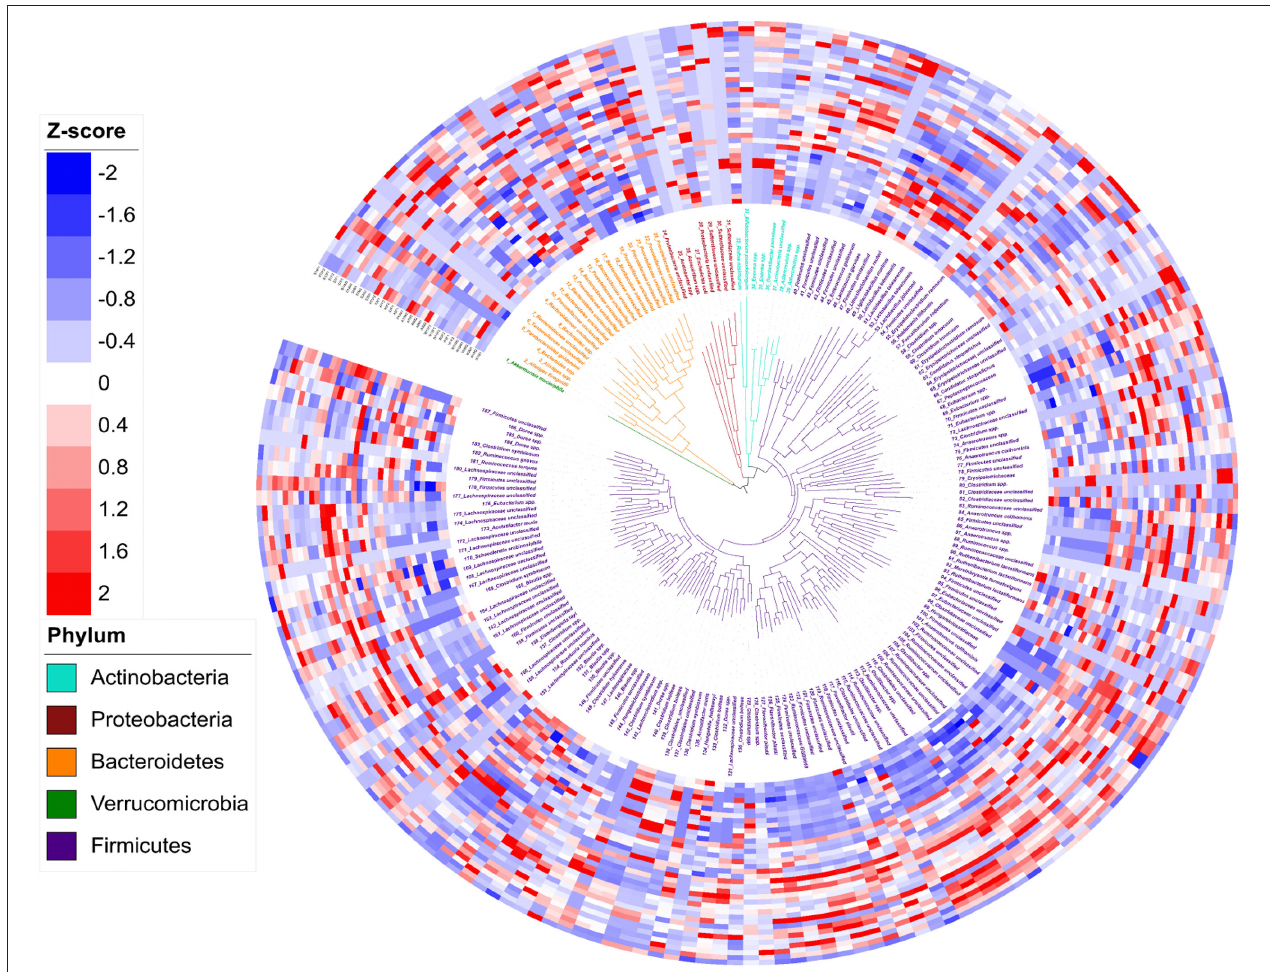
FIGURE 3 | Phylogeny and abundance of metagenomic assembled genomes recovered from 3-week old rat cecal digesta. The relative abundance of bins was calculated from percentage of re-mapped reads in the sample and presented as Z-score: Z-score = (relative abundance – mean of relative abundance)/standard deviation. Phylogenetic tree (the innermost layer) and taxonomic affiliations (the middle layer) of 188 metagenomic assembled genomes (MAGs). Tree branches and labels with different colors represent different phyla as indicated by the color code in the lower left. The outermost heatmap depicts the relative abundance of the 188 bins in each sample, inside to outside: Water Control (12 layers), Aspartame (12 layers) and Stevia (12